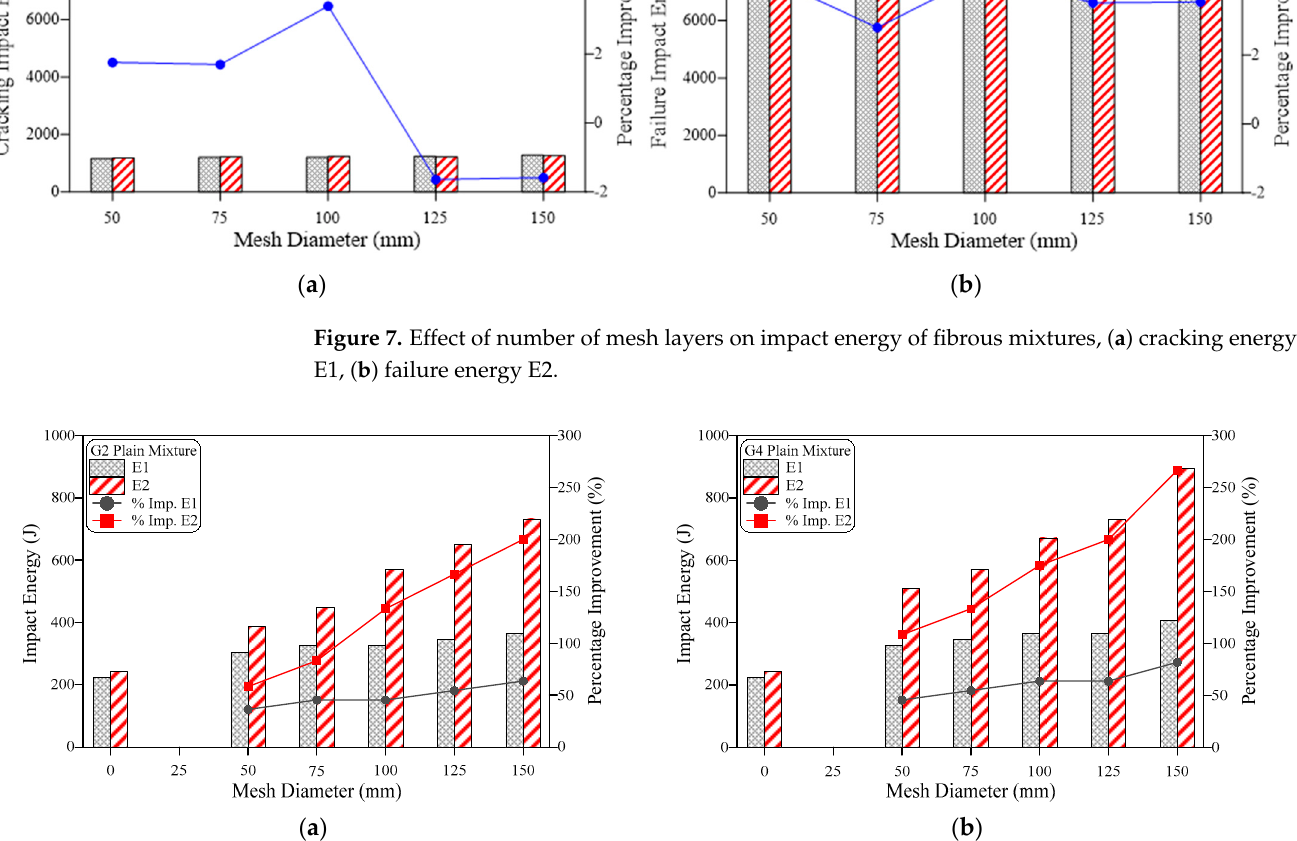
( a ) ( b ) Figure 9. Effect of mesh diameter (ratio of reinforcement surface) on impact energy of fibrous mix- tures, ( a ) 2-mesh layers, ( b ) 4-mesh layers. ( a ) ( b ) Figure 10. Effect of fiber on the impact energy of mixtures with 2-mesh layers, ( a ) cracking energy E1, ( b ) failure energy E2.